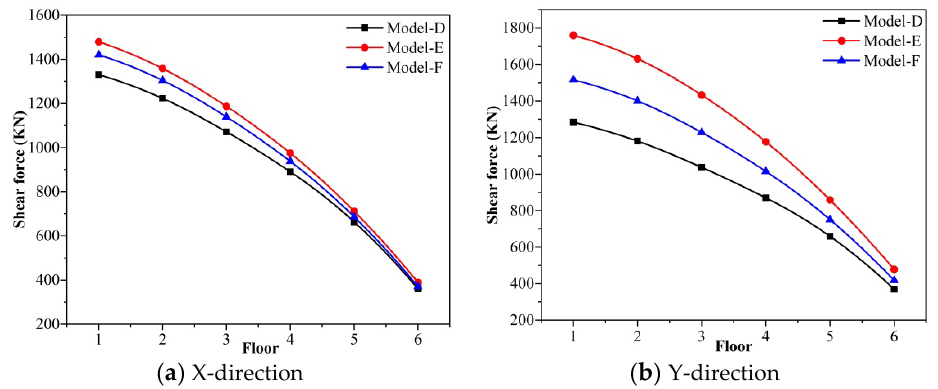
Figure 11. Aa comparison of max base shear of models.